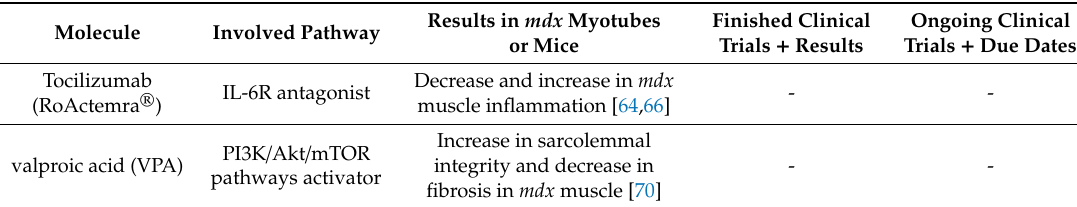
Table 4. Overview of Janus kinase / signal transducer and activator of transcription proteins (JAK / STAT) and mammalian target of rapamycin pathway (mTOR) stabilizing molecules: results in mdx myotubes (in vitro) or mice (in vivo), finished clinical trials and results, ongoing clinical trials and due dates, and putative